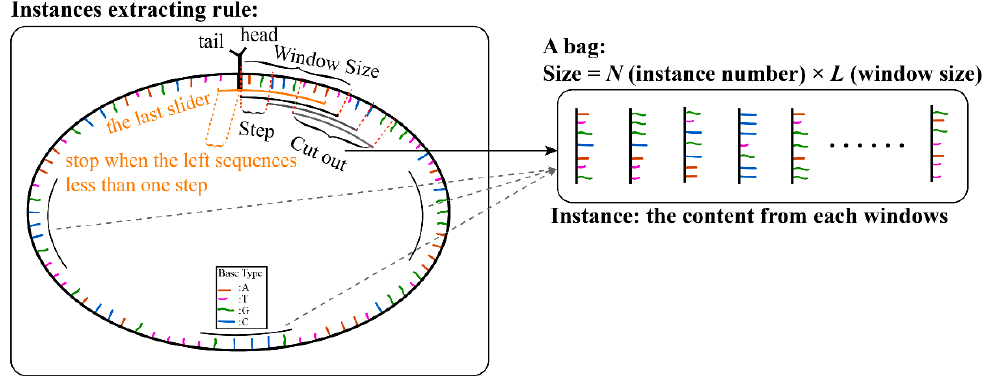
Figure 1. Illustrations of instance extraction from full RNA sequence.